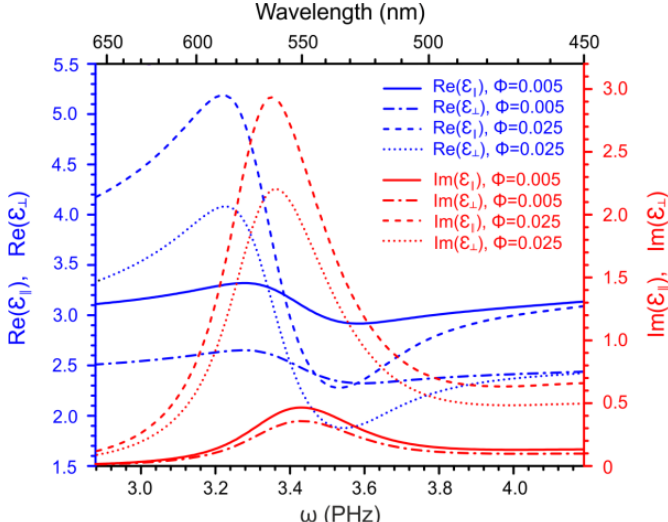
Figure 5. Frequency dependence of Re ( ε (cid:107) ) , Im ( ε (cid:107) ) , Re ( ε ⊥ ) and Im ( ε ⊥ ) of the nematic nanocomposite (host 5 CB plus AuNPs) for the two values of the NP volume fraction φ = 0.005 and φ =